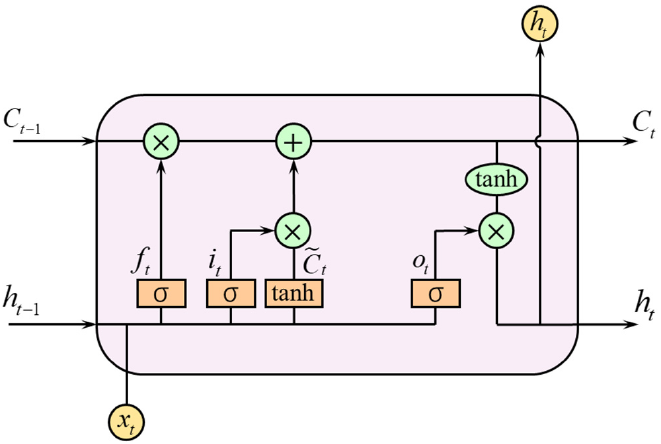
Figure 4. Unit structure of LSTM [40].